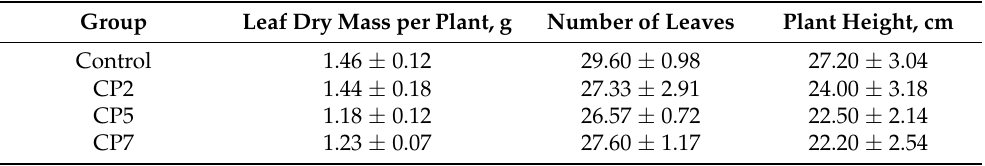
Table 2. Morphometric parameters of Stevia rebaudiana plants grown in the substrate for 12 weeks from control and CP-treated seeds. Group Leaf Dry Mass per Plant, g Number of Leaves Plant Height, cm Control 1.46 ±